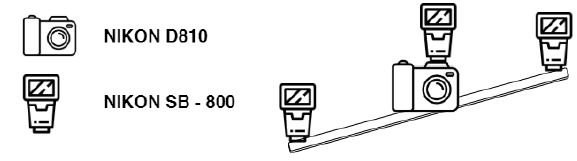
Figure 6 . The system used to obtain coherent lighting over all the pictures. The camera equipped with a speedlight flash is placed on the centre of a metal bar, and two other flashes are placed on both extremities.